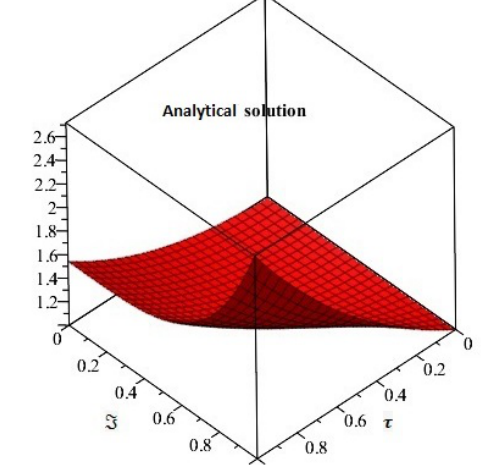
Figure 2. Represents the analytical solution of Example 1 at β = 2.